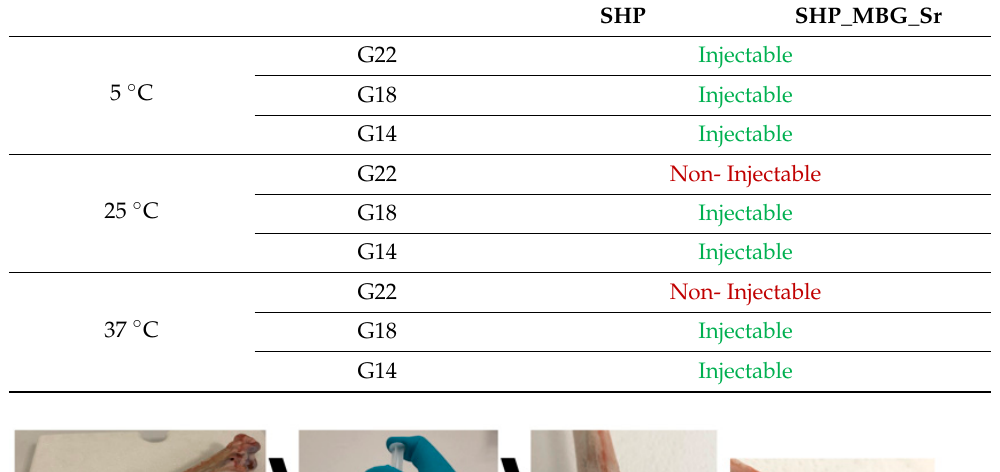
Table 1. Qualitative evaluation of injectability for SHP and SHP_MBG_Sr sol-gel systems. Tests were conducted by different users at three temperatures (i.e., 5, 25 and 37 °C) through three different